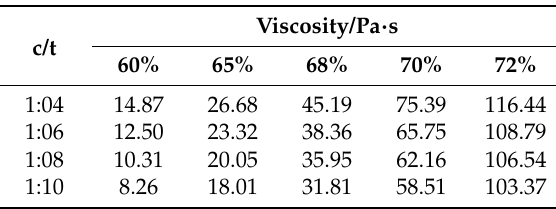
Table 4. Viscosity results of CTB samples.